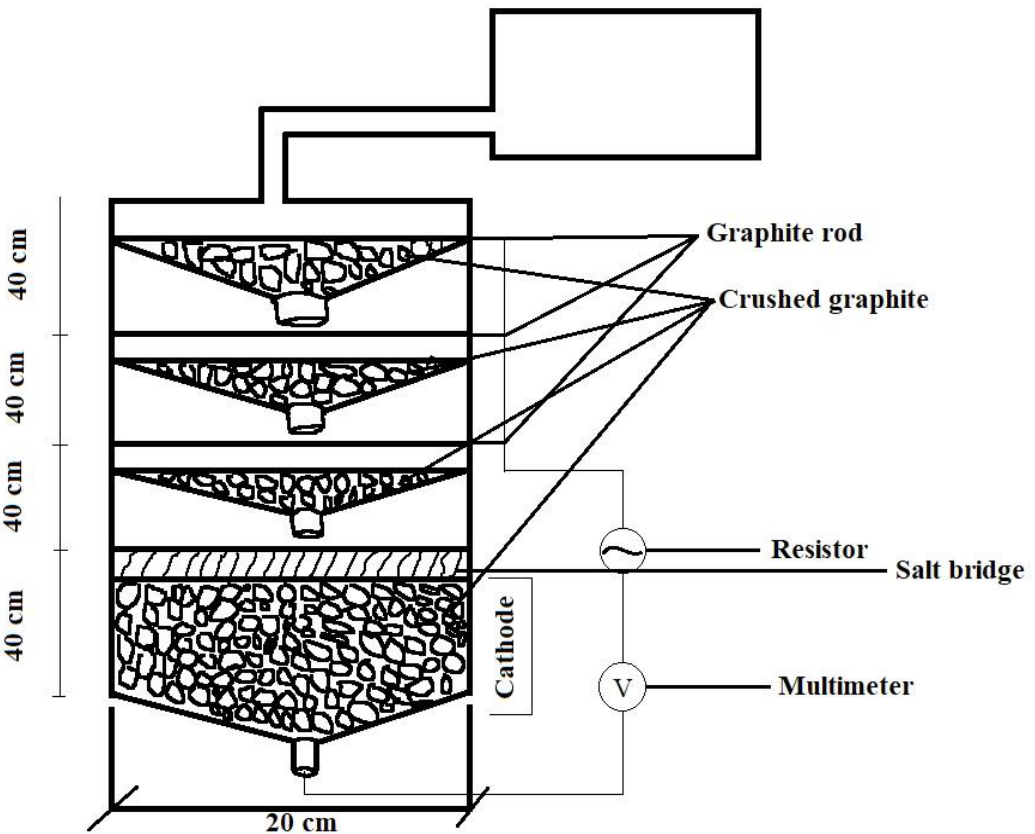
Figure 8. MFC arrangement of septic wastewater treatment (adapted from Leton et al. (2019) [68]).